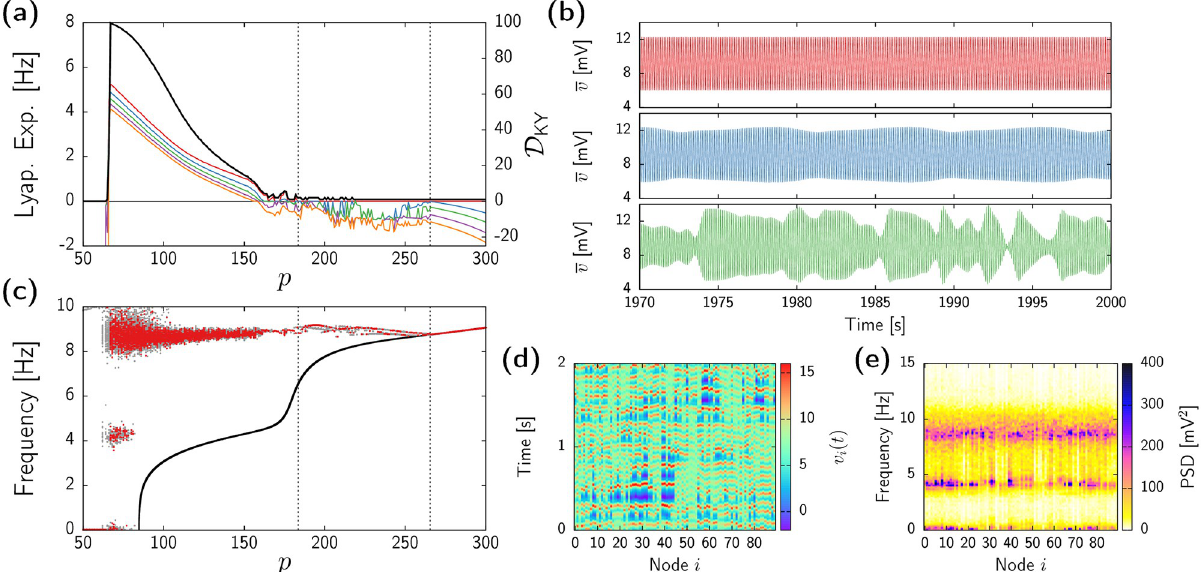
Fig 5. Onset of chaotic dynamics and multistable dynamics. (a) Five largest Lyapunov exponents (thin coloured lines, left axis) and Kaplan-Yorke dimension D (black thick line, right axis) for � = 50 and varying p , as obtained from direct integration of system (10). Simulations at each value of p KY were initialized at random. Vertical dashed lines indicate the onset of transverse instability (right, p ’ 265.5) and the onset of chaos (center, p ’ 184.5). (b) Time series of the mean-field voltage of the pyramidal neurons, � v , for p = 180 (top), 177 (middle), and 175 (bottom) and fixed � = 50. (c) Peak frequency of each network node. The black line shows the oscillation frequency of the underlying homogeneous state, as in Fig 1(f). Dots indicate the frequency for which the power spectral density is maximal for each node. Results from 5 simulations superimposed in gray, with one replicate highlighted in red. (d) Activity pattern of each node obtained from a simulation with p = 70 and � = 50. Only a time span of 2 seconds shown. (e) Power spectral density of each network node as obtained from the same simulation as in